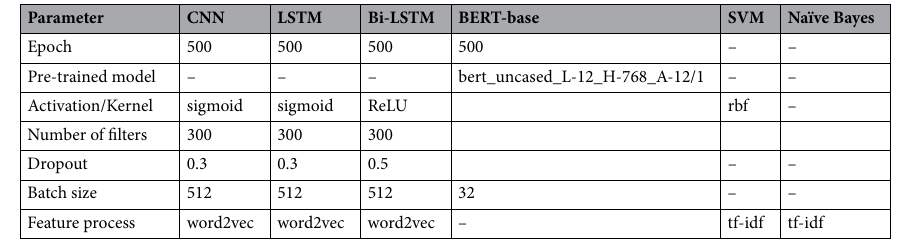
Table 3. Setting of models.